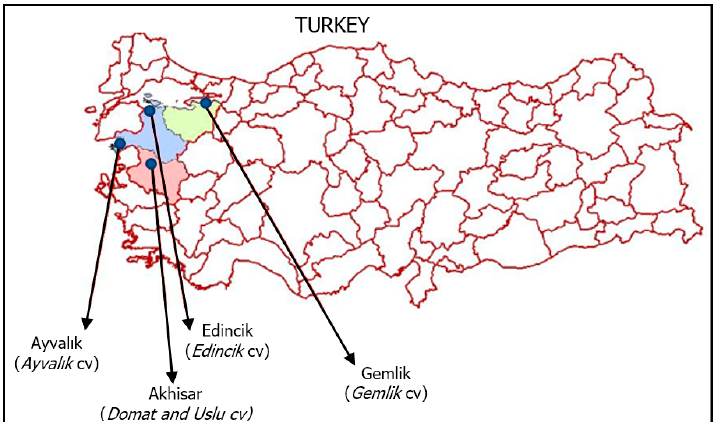
Figure 5. The geographical distribution of olive cultivars used for oil samples.